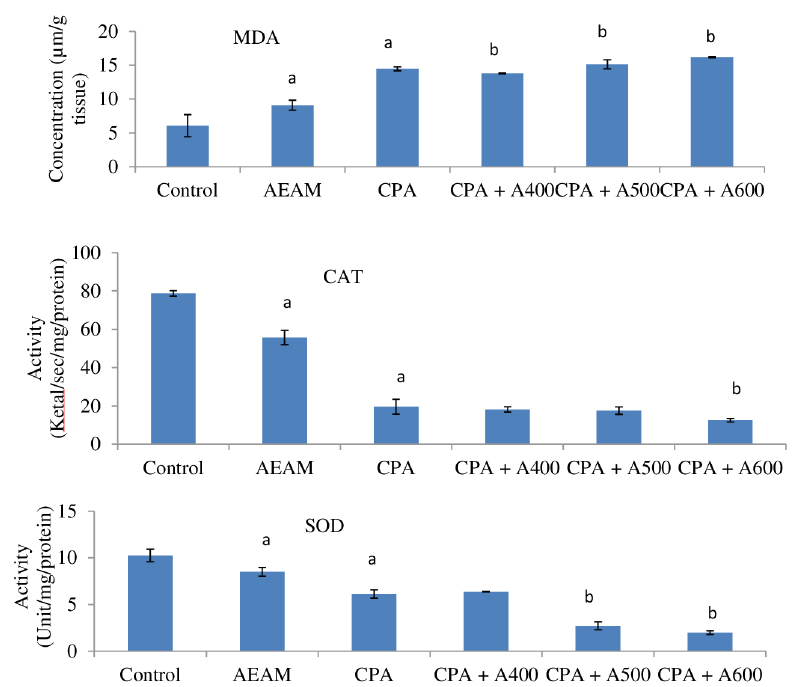
FIGURE 2 - Effect of aqueous extract of A. marmelos on CPA-induced toxicity on the activities of MDA, SOD and CAT were carried out in testis. Each bar represents the Mean ±SE, n=6; ‘a’ indicates the significant difference between the control and CPA treated groups, ‘b’ indicates the significant difference between the CPA treated and AEAM treated groups. Significant at p